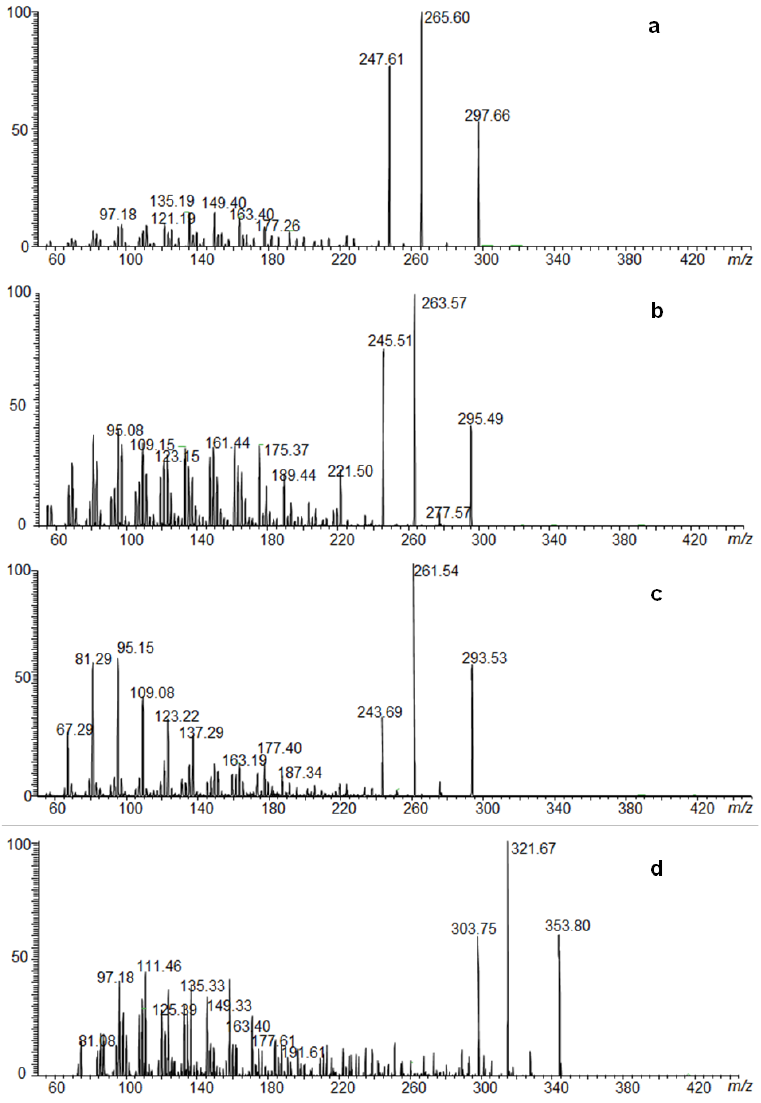
Figure 1. ESI(+)-MS/MS spectra of [M+H] + ions of oleic acid methyl ester ( a ), linoleic acid methyl ester ( b ), linolenic acid methyl ester ( c ), erucic acid methyl ester — IS ( d ).